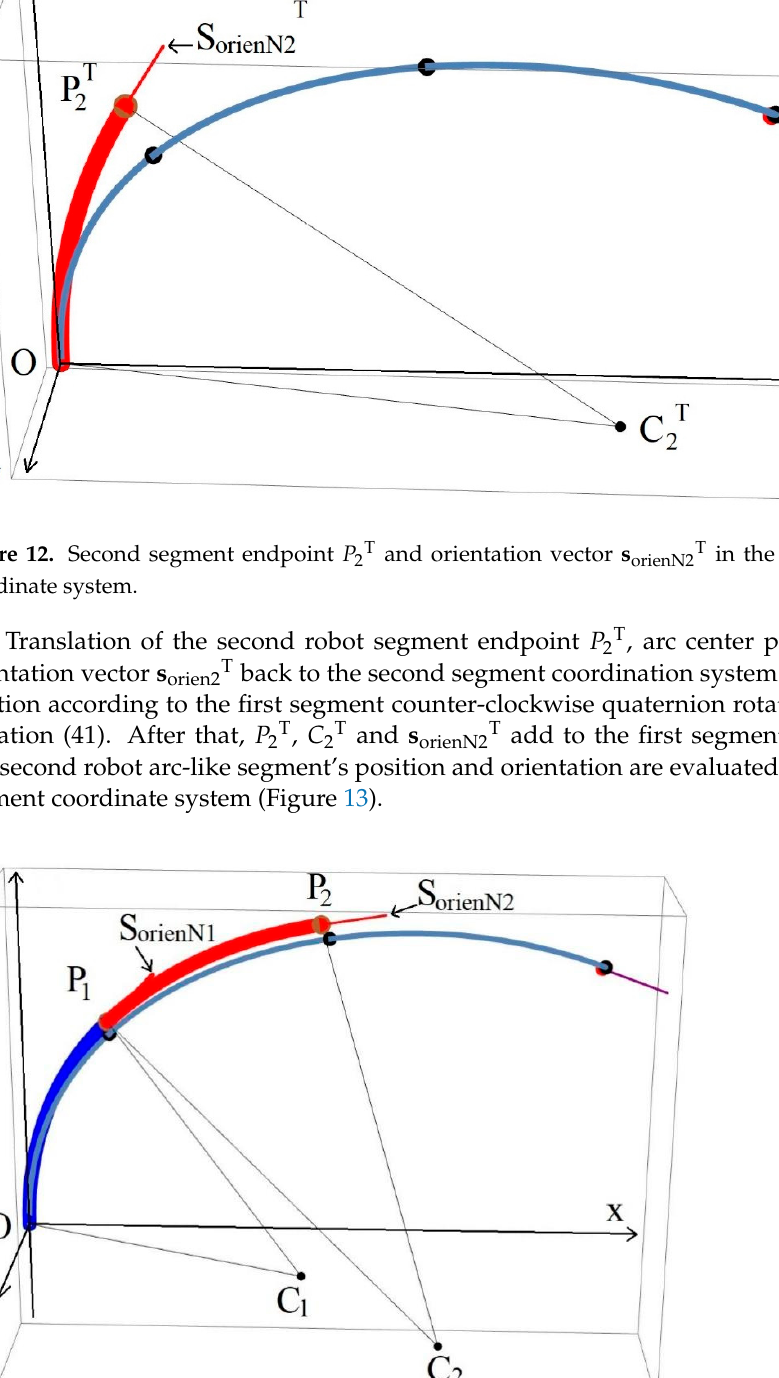
Figure 11. Second segment vector (cid:1816) (cid:2915)(cid:2913)(cid:2870)(cid:2904) calculation representation. The estimated vector (cid:1816) (cid:2898)(cid:2915)(cid:2913)(cid:2870)(cid:2904) lies in the first segment coordinate system. Getting the